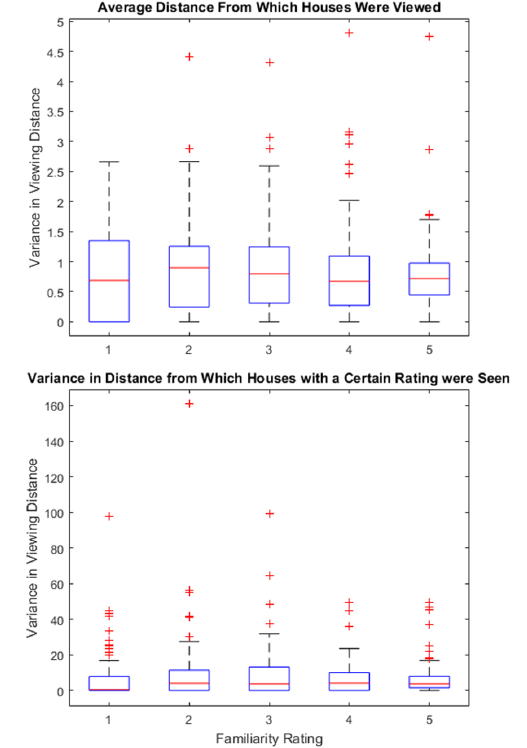
Figure 12: (Top) Average distance from which a house was seen. (Bottom) Average variance in distances.